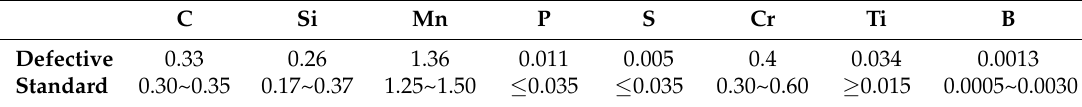
Table 1. Chemical composition of defective product and specifications for 33MnCrTiB, wt-%.